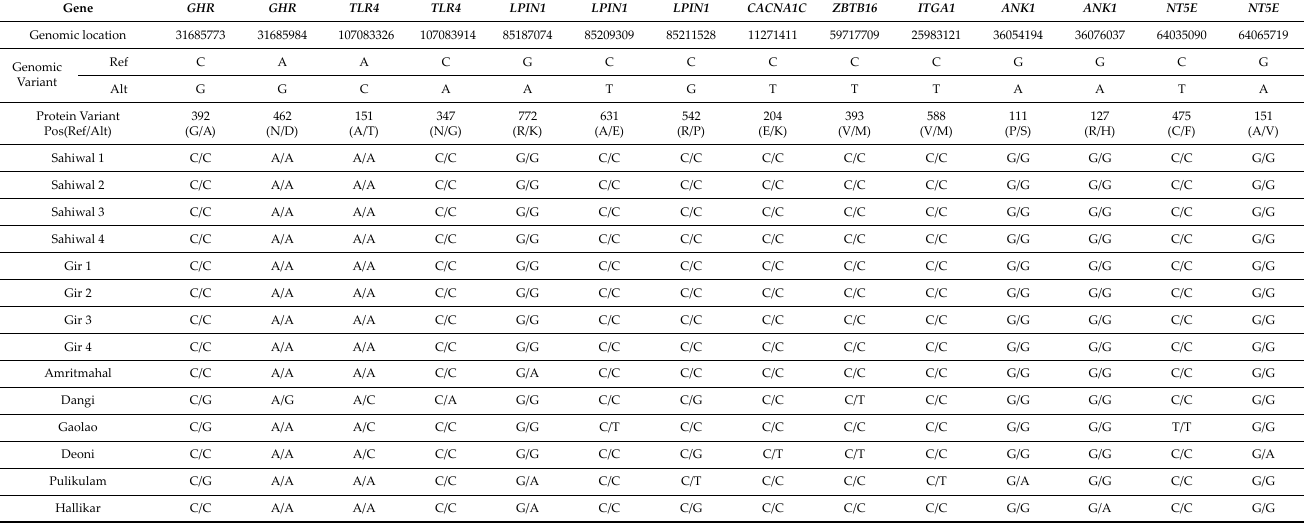
BiSNP, biallelic SNP. Table 3. Genes with a fixed SNP pattern in high‑milk‑yield breeds (Sahiwal and Gir) and the re‑ spective variable SNP pattern in low‑milk‑yield breeds (Gaolao, Deoni, Pulikulam, Hallikar, Dangi, and